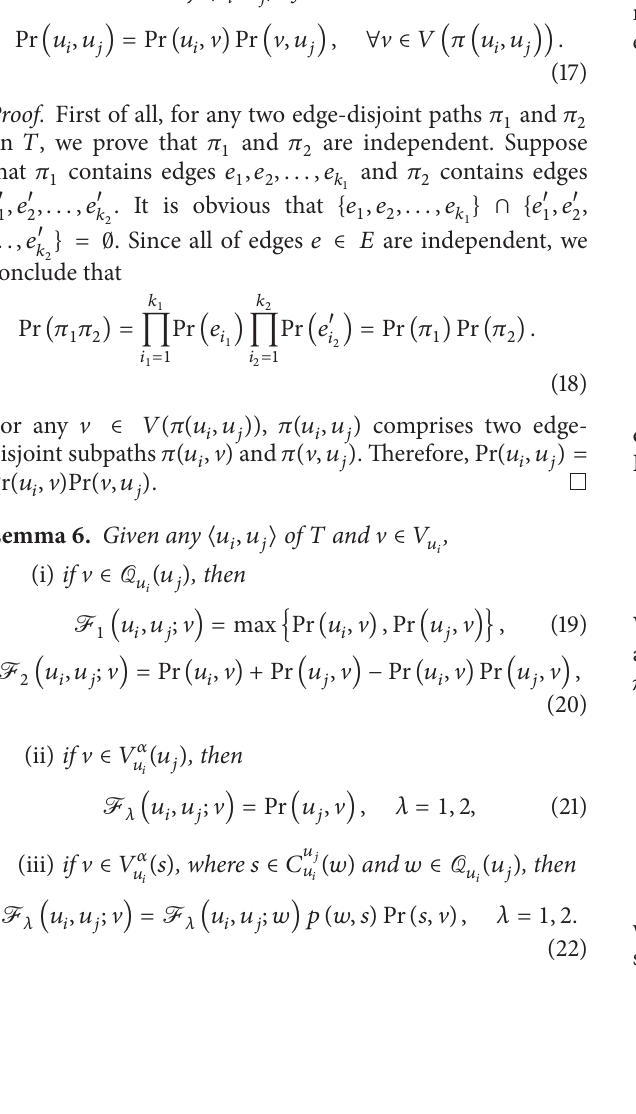
for any 𝑢 𝑖 ∈ 𝑉 𝑖